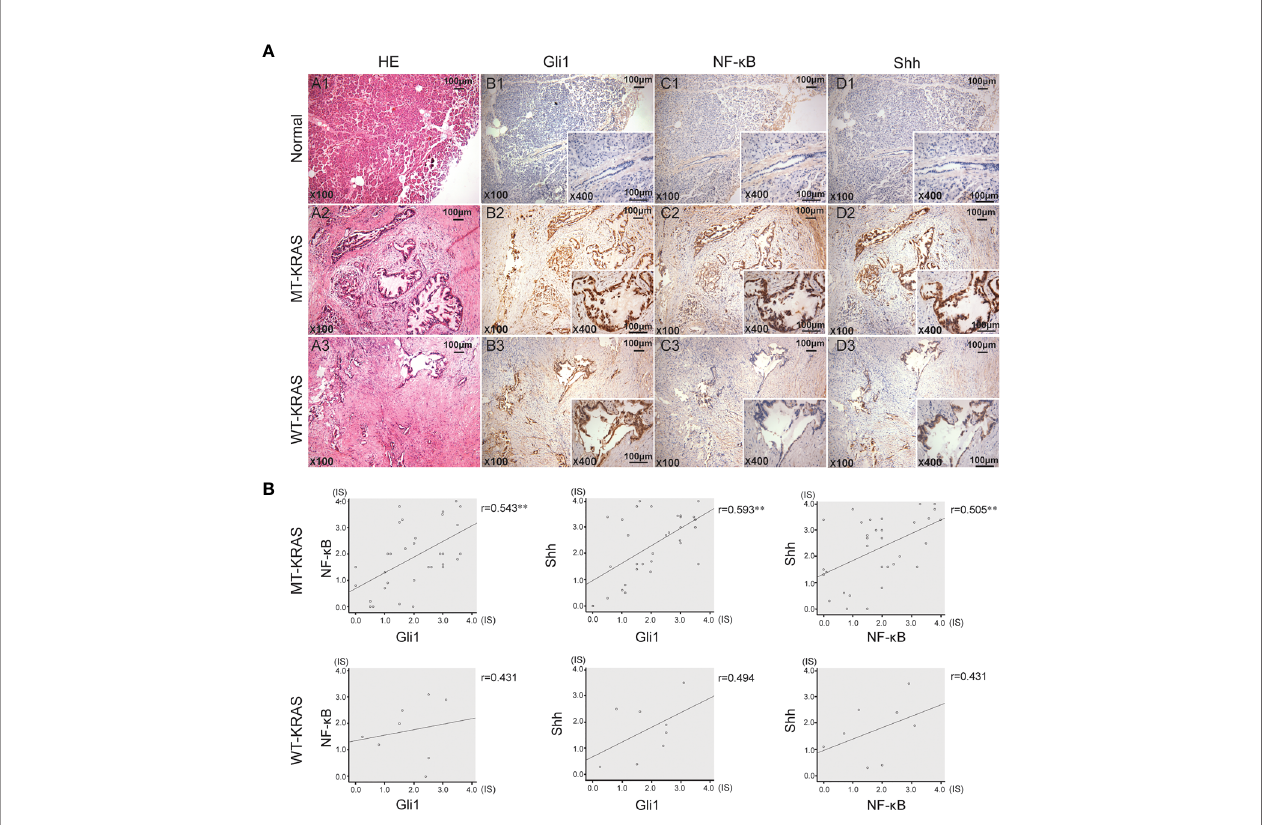
FIGURE 1 | Gli1, NF- k B p65 and Shh protein expression in PDAC tissues with or without KRAS mutation. (A) Typical serial PDAC tissue section. HE staining and IHC staining for Gli1, NF- k B p65 and Shh proteins in the normal tissue (A1, B1, C1 and D1), MT-KRAS PDAC tissues (A2, B2, C2 and D2) and WT-KRAS PDAC tissues (A3, B3, C3 and D3). (B) Correlation of Gli1, NF- k B p65 and Shh protein expressions in the MT-KRAS and WT-KRAS PDAC tissues. **p < 0.01,